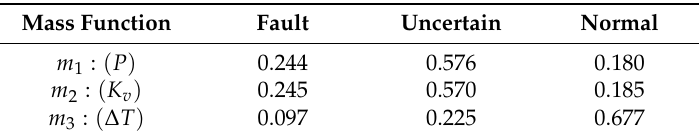
Table 2. The mass functions.